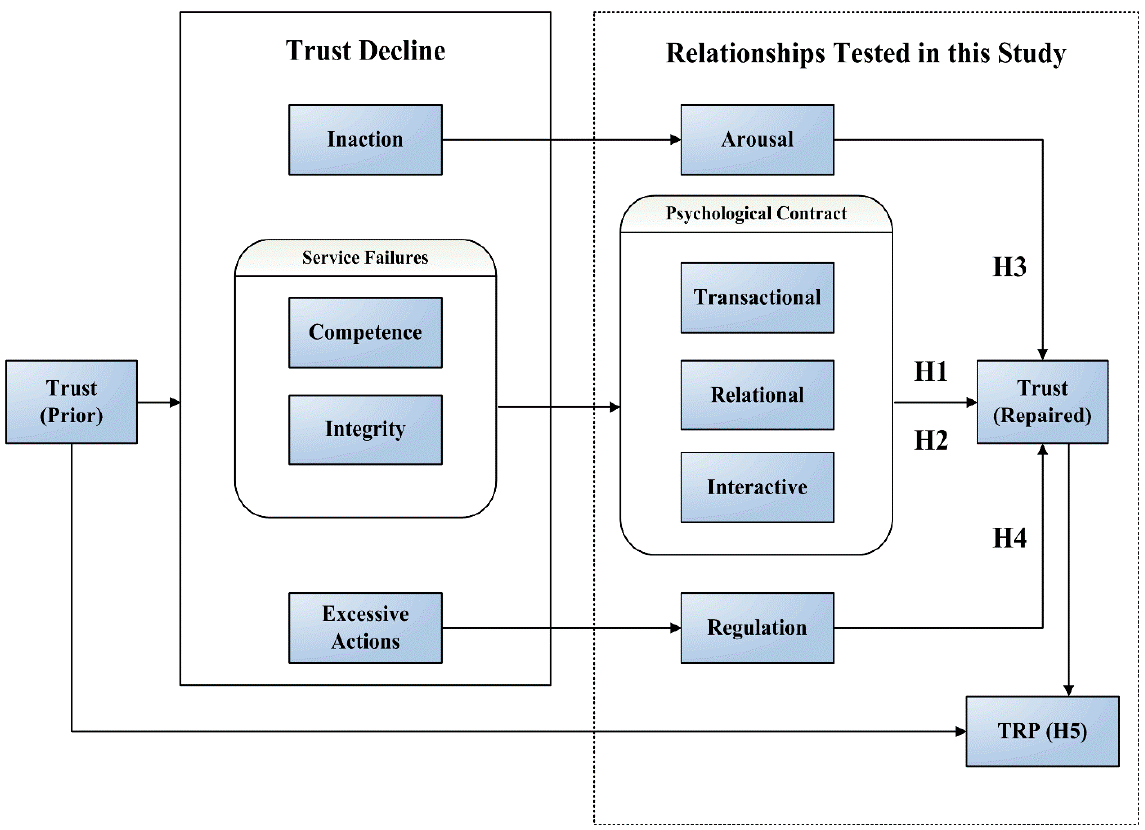
Figure 1. Consumer Trust Repair Model. 278